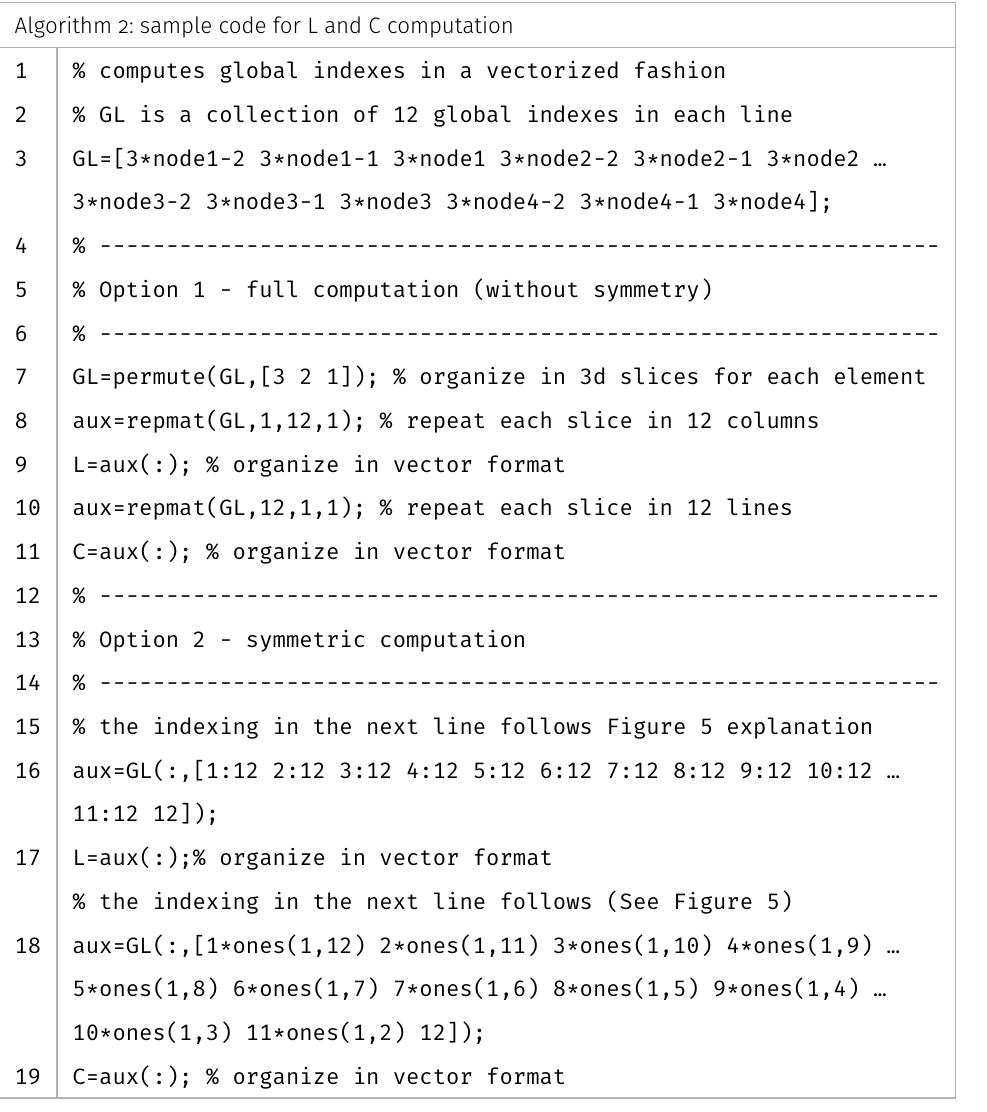
Algorithm 2: sample code for L and C